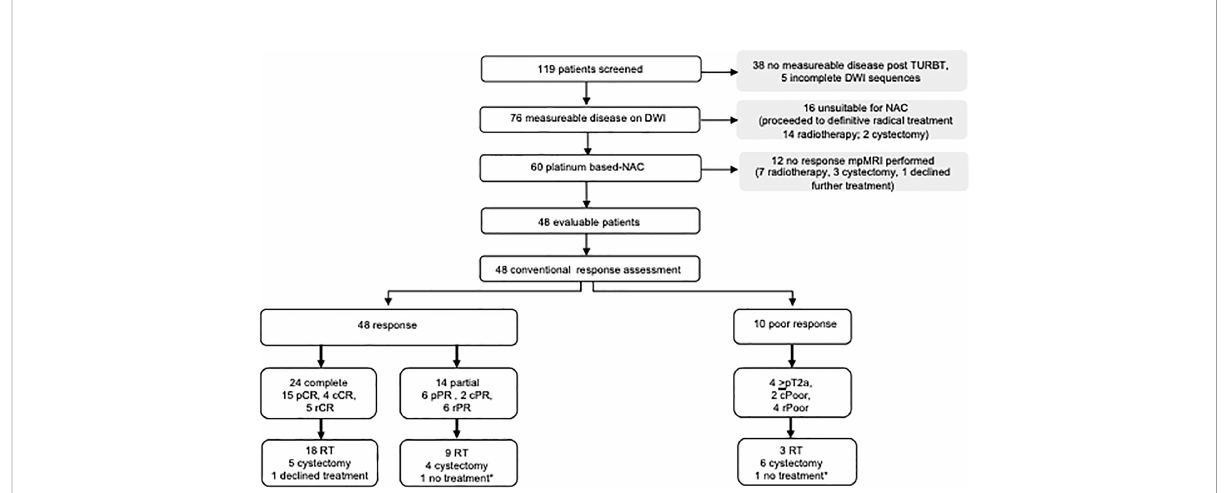
FIGURE 1 Patient study fl ow. NAC, neo-adJuvant chemotherapy; DWI, diffusion weighted MRl scan; pCR, pathological complete response; cCR, clinical complete response on cystoscopy; pPR, pathological partial response; rCR, radiological complete response; rPR, radiological partial response; cPoor, clinical poor resposnse on cystoscopy; rPoor, radiological poor response, RT-radiotherapy. *death pnor to de fi nitive radical treatment due to cause unrelated to bladder cancer or